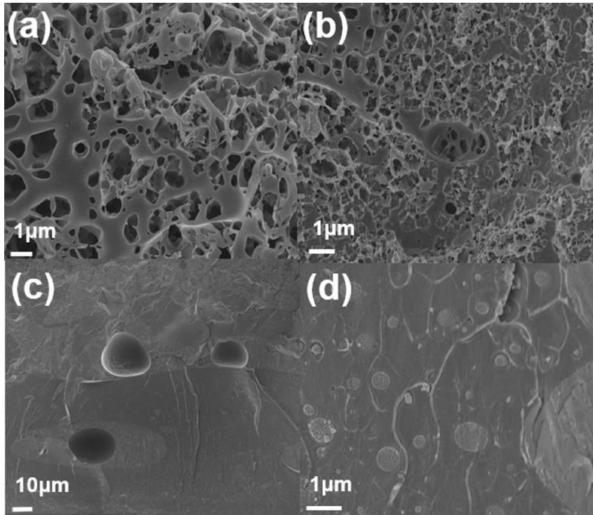
Figure 8. The SEM cross-section images of the PMMA / PS(50 / 50) blends. ( a , b ) PS phase-etched blend PMMA / PS(50 / 50) and ( c , d ) PMMA / PS(50 / 50) without